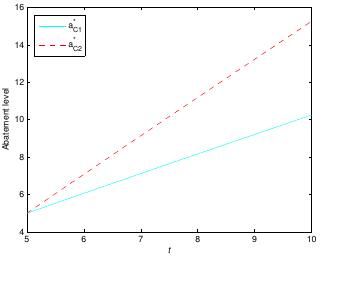
Figure 2. The abatement levels of the cooperative transboundary pollution problems in Wanzhou District, Kaizhou District and Yunyang County.